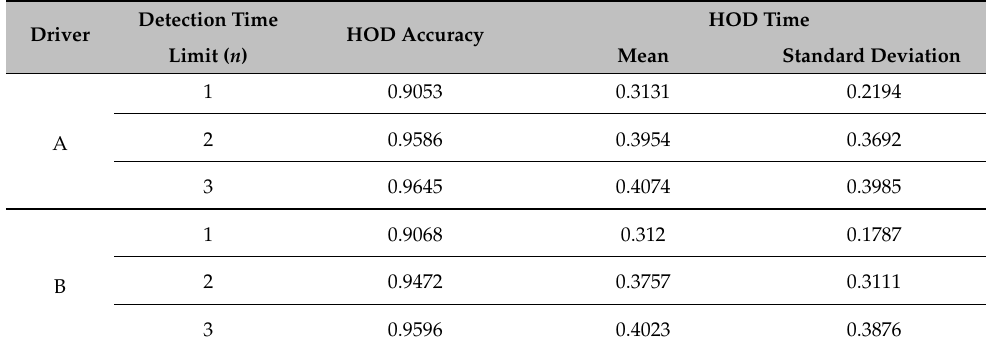
Table 10. HOD accuracy and time on the new driver data (time window size = 10). The unit of detection time limit and HOD time is second.